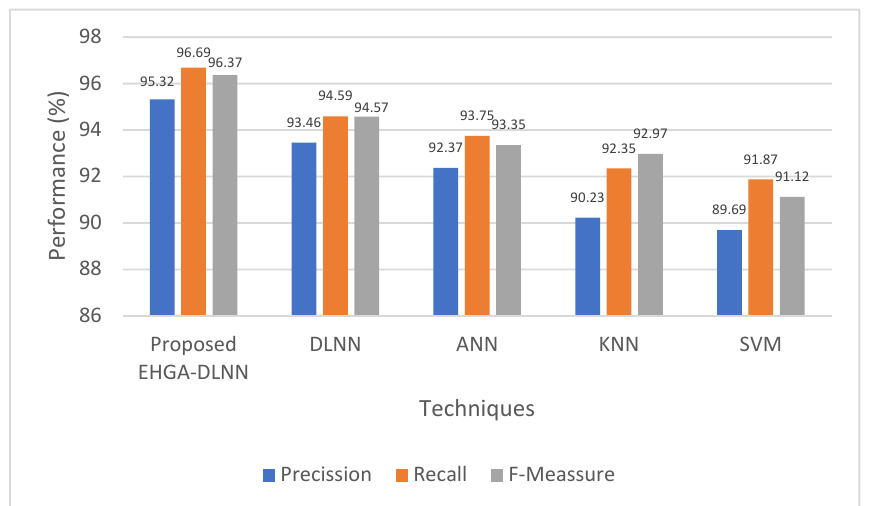
Figure 5. Precision, recall, and F-measure graph for the proposed methodology.